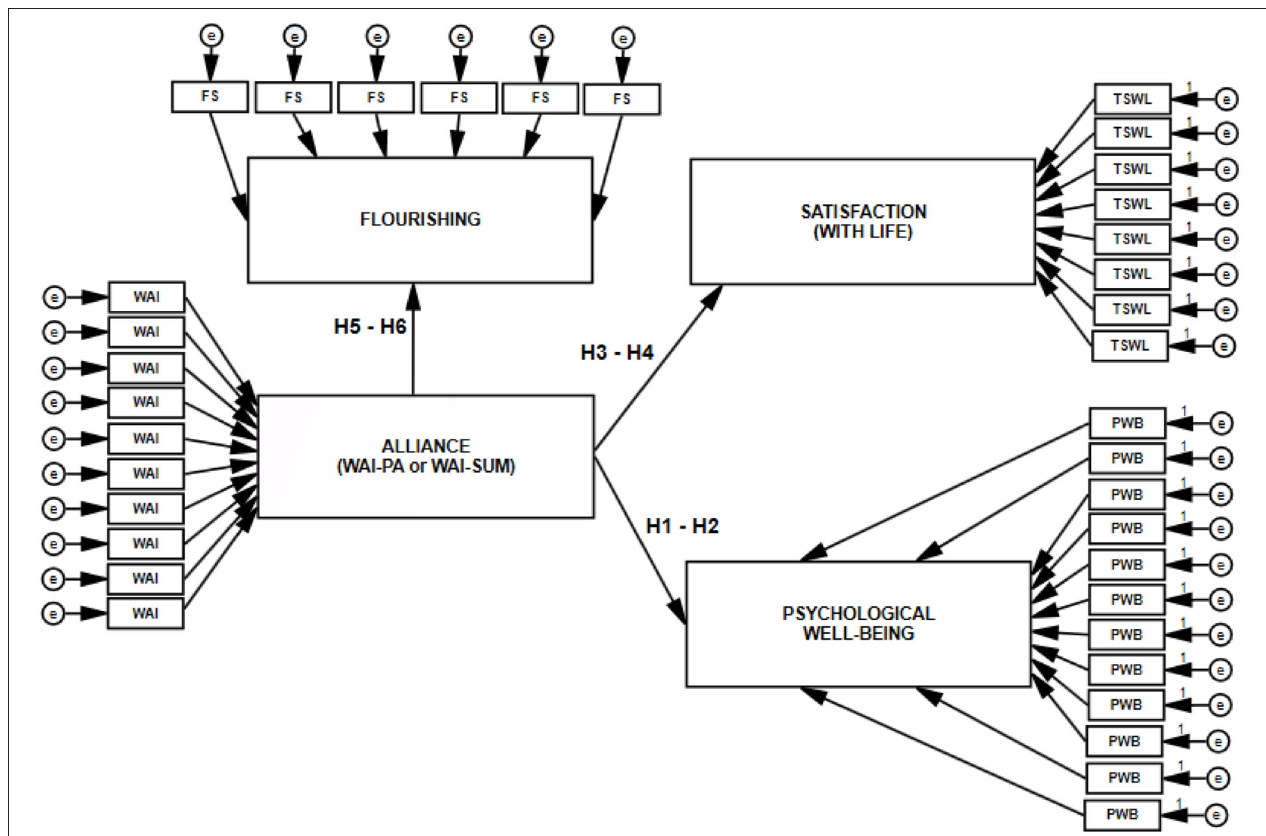
FIGURE 1 | Model of direct relations of working alliance to well-being, life satisfaction, and flourishing. WAI-PA, isolated assessment of alliance based on patient’s evaluation; WAISUM, assessment of alliance based on patient’s and psychotherapist’s evaluations; WAI, FS, TSWL, PWB, measures of the variables; e, random